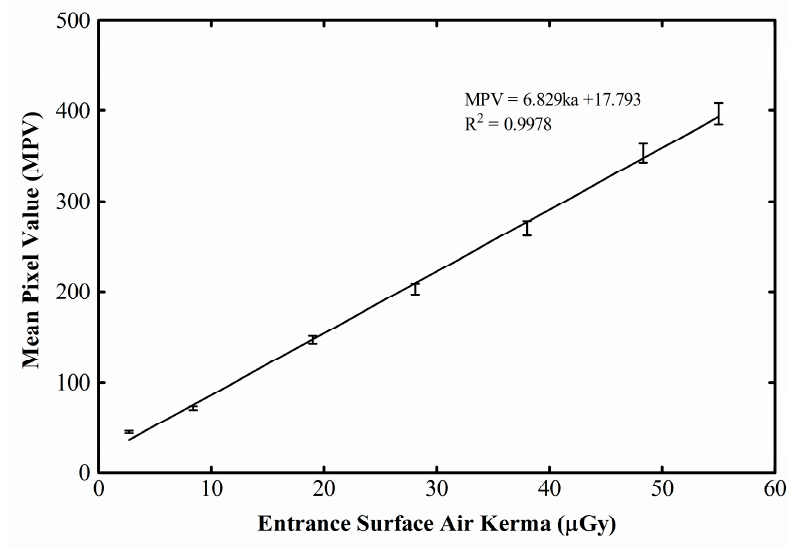
Figure 1. STP curve of the CMOS X-ray detector.